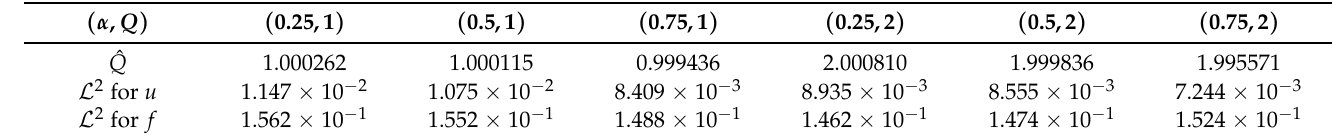
Table 2. Fractional partial differential equation: estimated values of Q and the relative error L 2 for u ( t , x ) and f ( t , x ) where N u = 15, N f = 12, ( α , Q ) is fixed to be (0.25, 1), (0.5, 1), (0.75, 1), (0.25, 2), (0.5, 2) and (0.75, 2), in